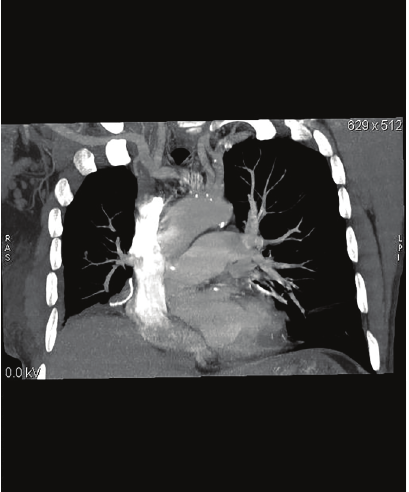
Figure 2: Another coronal oblique CT image denoted a PAPVC from the right upper lobe to the superior vena cava (arrow).